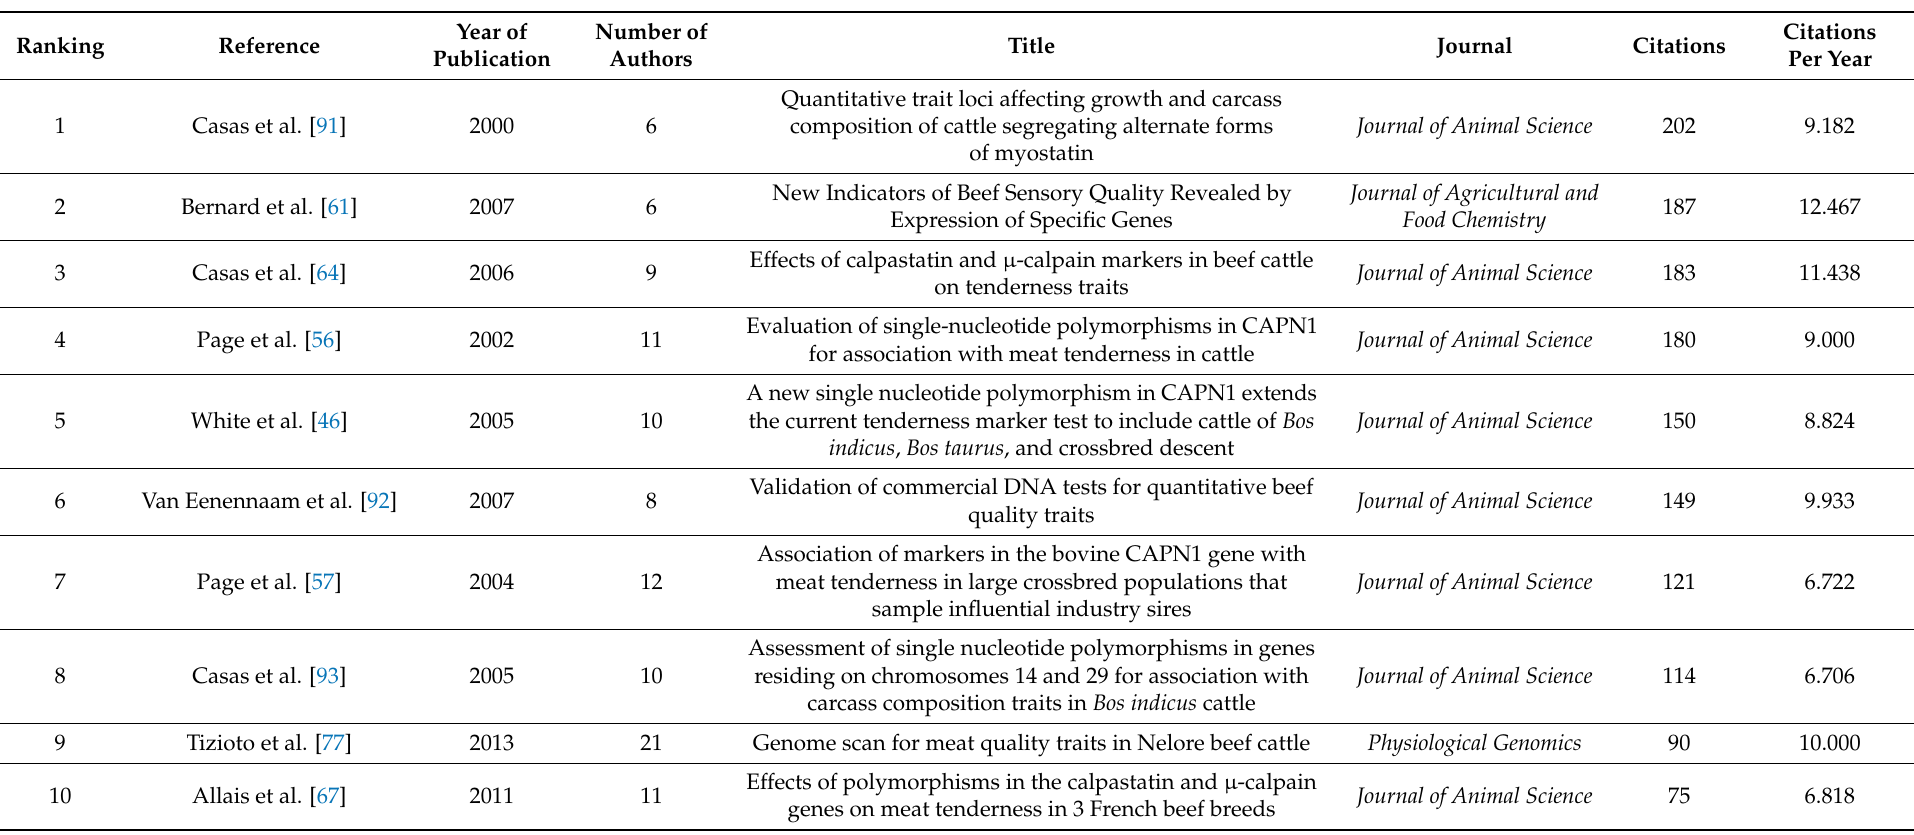
Table 5. Most cited articles on the field of